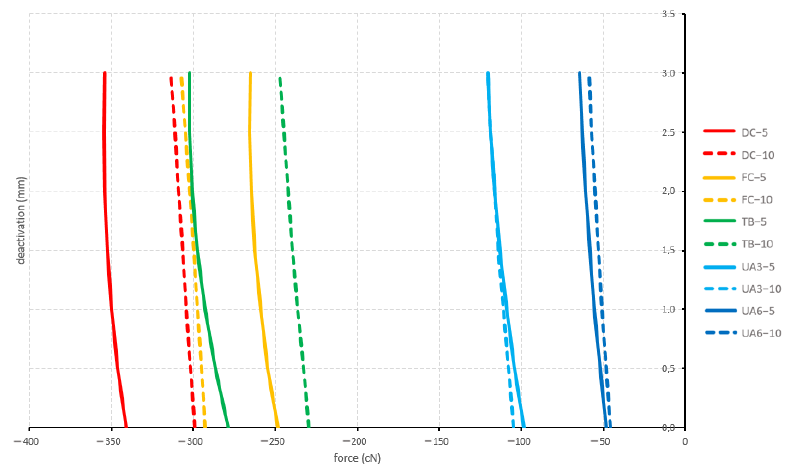
Figure 14. Medial/lateral forces generated by the straight configurations during deactivation (medial positive; lateral negative). Tested cantilever configurations origin from Figure 2.